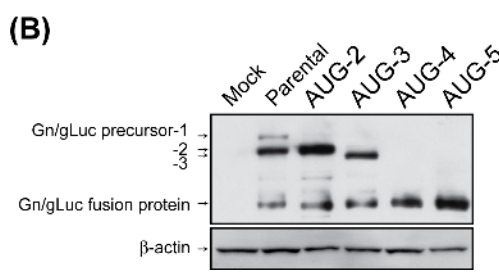
Figure 3. Relative expression of precursor proteins and cleaved gLuc after the truncation of the viral sequence upstream of AUG. ( A ) Schematic representation of AUG2-M, AUG3-M, AUG4-M, or AUG5-M, which express a single precursor from the 2nd, 3rd, 4th, or the 5th AUG, respectively. AUG2-M lacks the 3rd, 4th, and 5th AUGs, AUG3-M lacks the 4th and 5th AUGs, and AUG4-M lacks the 5th AUG. The mutant plasmids encode a common 20 nucleotide viral sequence upstream of the 1st AUG (5 ′ -ACACAAAGACGGUGCACGAGAUG (initiation codon is underlined)); ( B ) 293 cells were co-transfected with pSV40-CLuc (transfection control), and pCAGGS-PreGn-gLuc-SF or the mutant plasmids. At 36 h post transfection, culture supernatants were collected, and the gLuc and cLuc activities were measured. Then, the ratio of gLuc to cLuc was normalized to that of parental pCAGGS-PreGn-gLuc-SF plasmid. The graph represents the mean + the standard error of three independent experiments. Asterisks represent statistically significant differences (one-way ANOVA followed by Tukey’s multiple comparisons test, * p < 0.05, ** p < 0.01).